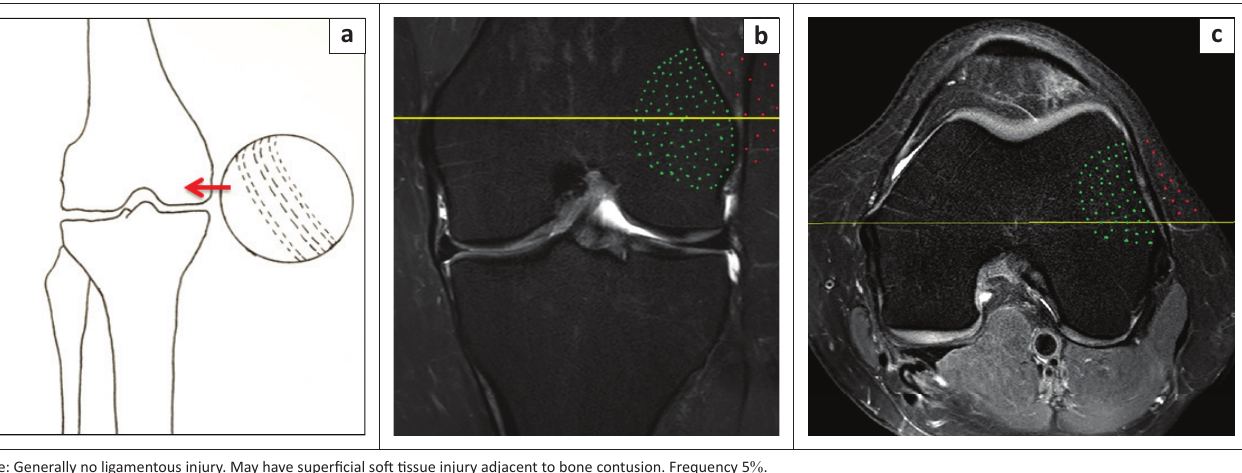
FIGURE 10: Direct trauma: (a) Schematic depicts direct trauma to medial right knee with associated soft tissue contusion and bone bruise depicted in the medial femur condyle (b) and